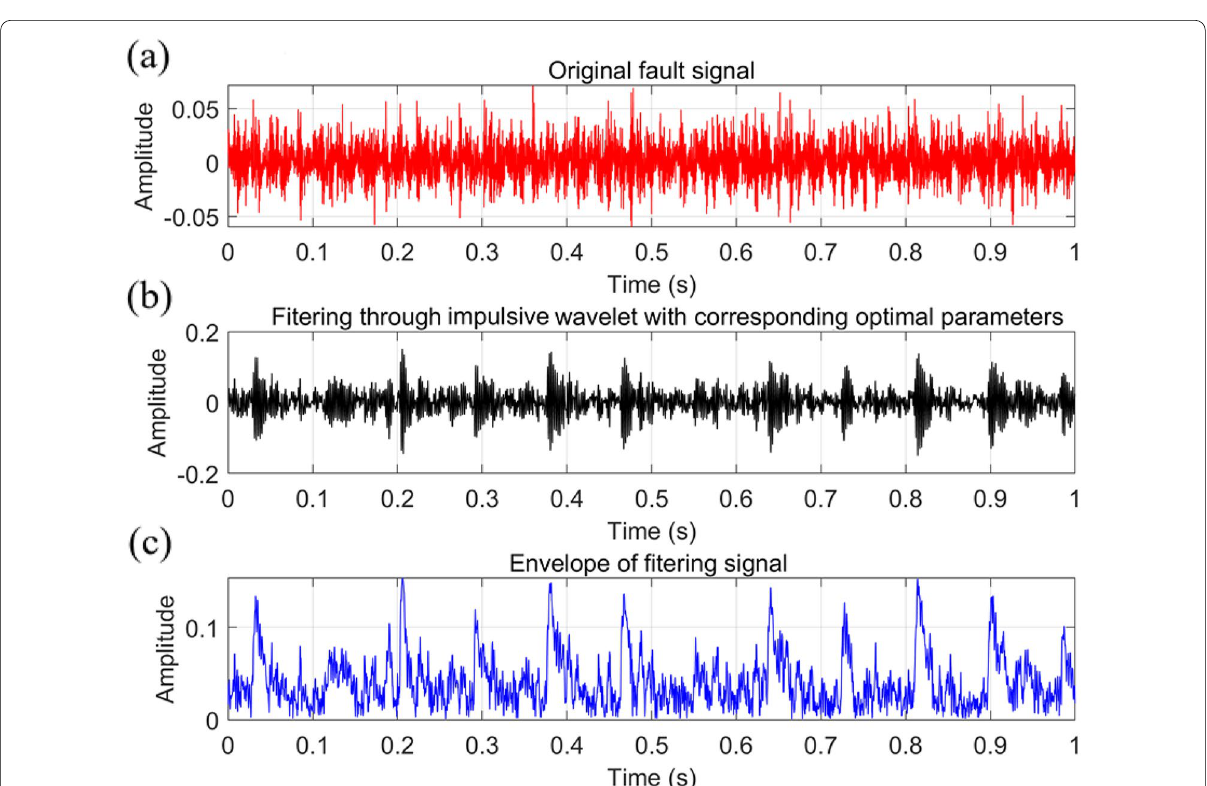
Figure 27 Root crack fault signal processed by the proposed method: ( a ) original signal, ( b ) signal after filtering by impulsive wavelet, and ( c ) envelope of the processed signal